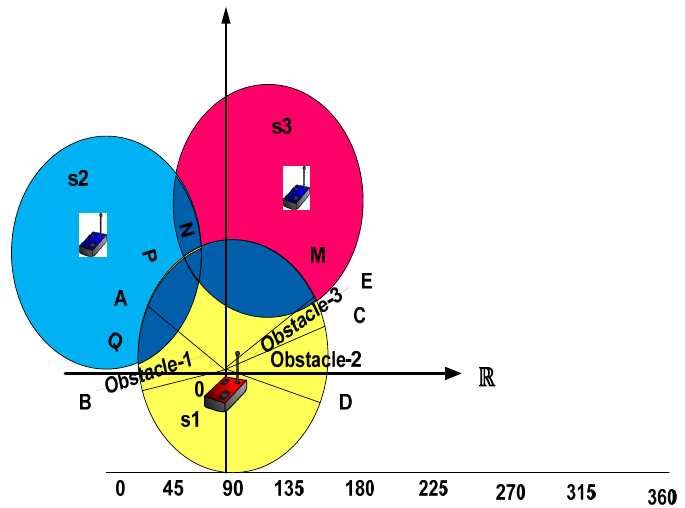
Figure 4. Obstacles within the node boundary and viewpoint; the yellow area represents the viewpoints of first sensor, the blue represents the viewpoints of the second sensor, the red represents the viewpoints of the third sensor and the dark blue represents the overlapped viewpoints area of the sensors.